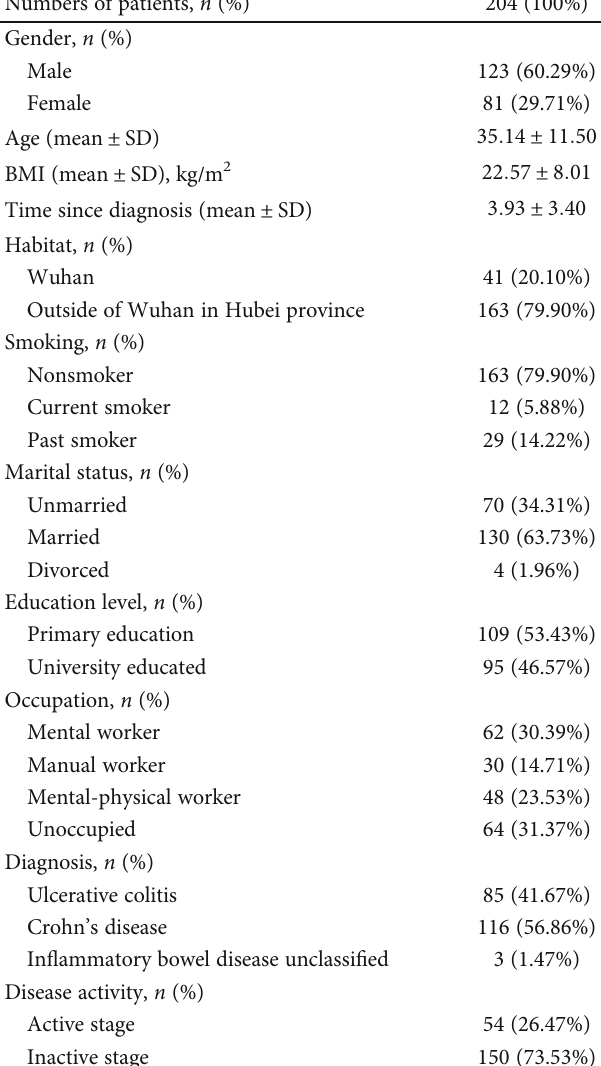
Table 1: Characteristics of the patients with IBD responding to the